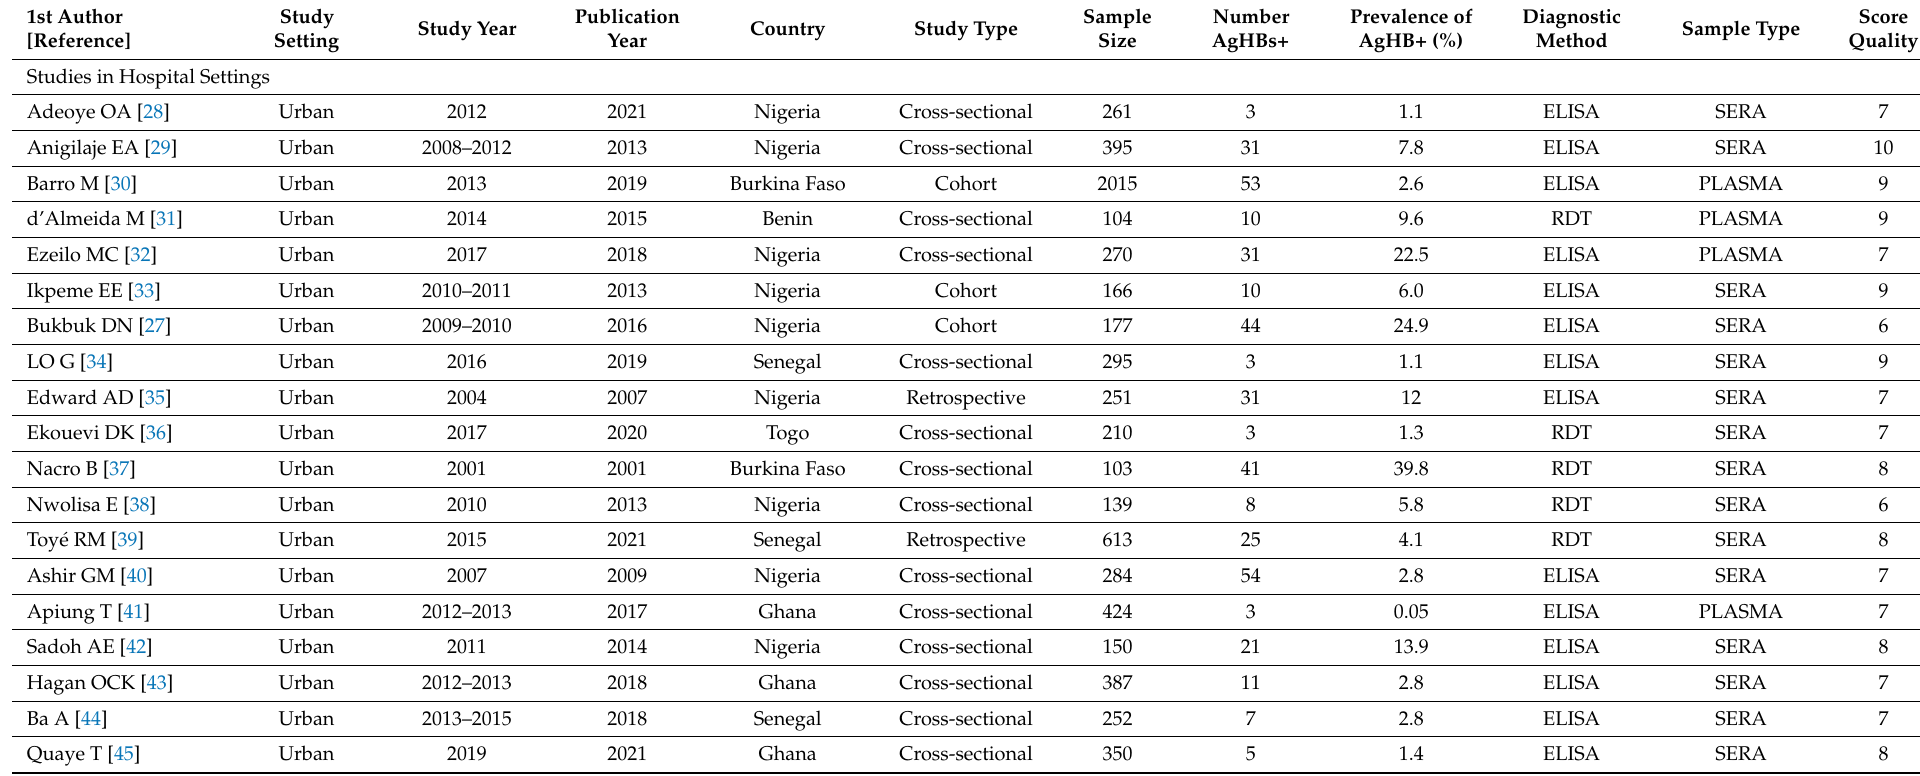
Table 1. Characteristics of Systematic Review Studies and Meta-Analysis of HBV Prevalence in Children in West